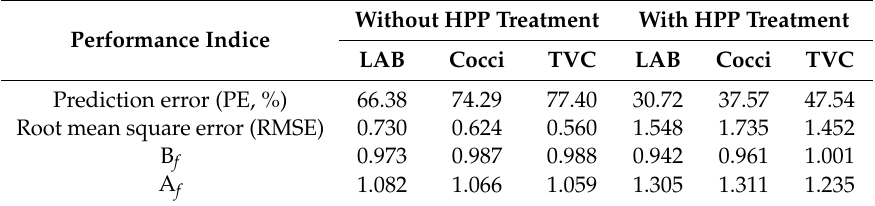
Table 1. Performance indices of the partial least squares (PLS) regression (PLS-R) model, correlating the lactic acid bacteria (LAB), lactococci / streptococci and total viable counts (TVC) in each group of ham samples with regards to the high pressure processing (HPP) application, on the basis of FTIR spectral data. Without HPP Treatment With HPP Treatment Performance Indice LAB Cocci TVC LAB Cocci TVC Prediction error (PE, %) 66.38 74.29 77.40 30.72 37.57 47.54 Root mean square error (RMSE) 0.730 0.624 0.560 1.548 1.735 1.452 B f 0.973 0.987 0.988 0.942 0.961 1.001 A f 1.082 1.066 1.059 1.305 1.311